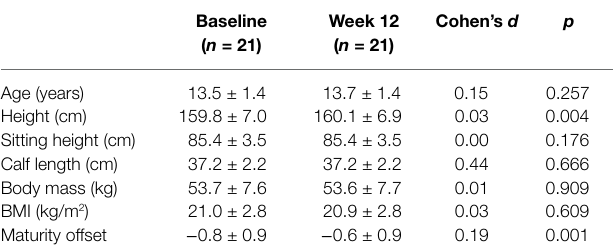
TABLE 1 | Characteristics (mean ± SD) of the participants.